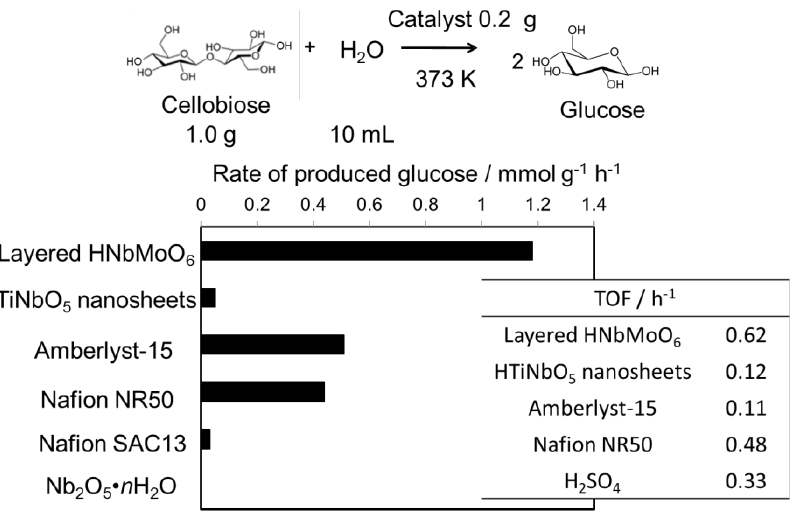
Figure 3. Hydrolysis of cellobiose over layered HNbMoO 6 solid acid.